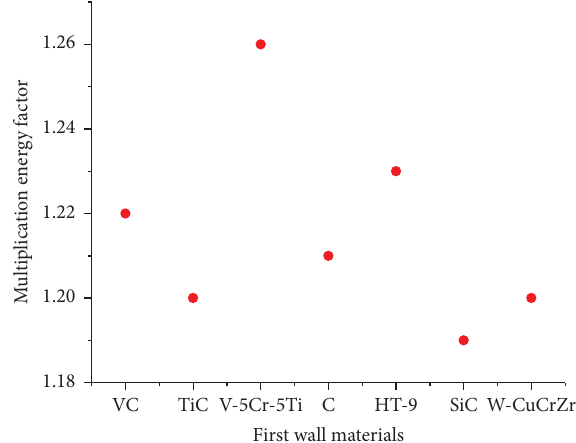
Figure 11: A multiplication energy factor ( M ) on the frst wall (FW) zone.